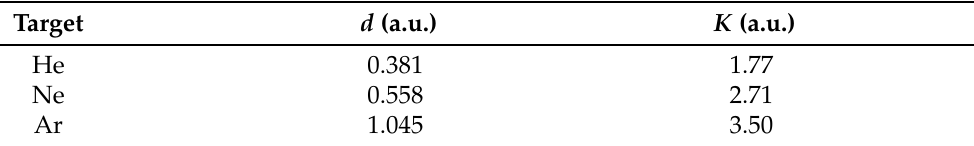
Table 1. Parameters d and K of the GSZ potential for the different targets considered, extracted from